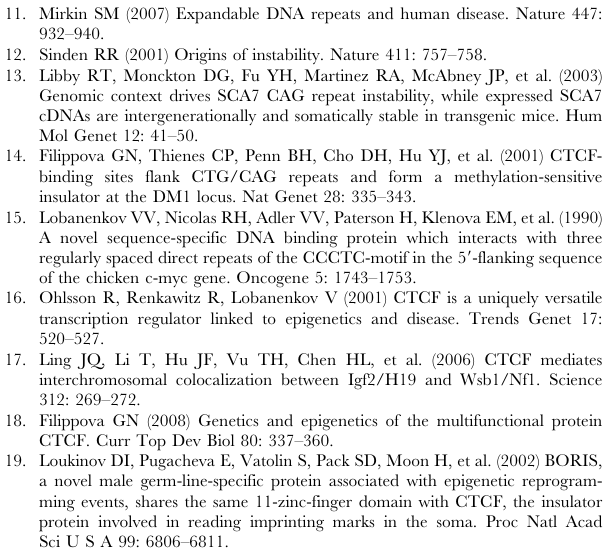
indicate shifted CTCF-DNA complexes, shifted BORIS-DNA complexes, and super-shifted BORIS-DNA complexes. Addition of CTCF-DM1 probe as cold competitor prevented CTCF-DNA and BORIS-DNA complex formation for the SCA7-CTCF-I -wt fragment, while non-specific cold competitor did not (data not shown). Figure S3 Increased somatic instability in both SCA7-CTCF -I- mut transgenic lines. Here, we see representative results for PCR analysis of somatic repeat instability for aged individuals from each of the two SCA7-CTCF-I -mut transgenic lines analyzed in this study. Note that comparable patterns of increased somatic mosaicism are observed in each lineage. Figure S4 Comparable somatic mosaicism in both SCA7-CTCF- I -mut transgenic lines. Here, we see representative images for PCR analysis of somatic repeat instability for 5 month-old individuals from each of the two SCA7-CTCF-I -mut transgenic lines analyzed in this study. Note that comparable patterns of increased somatic mosaicism are again observed at this earlier point. Figure S5 Methylation of SCA7-CTCF-I-wt probe fragment for gel shift analysis. Sss I was used to methylate cytosine residues in CpG dyads in the SCA7-CTCF-I -wt probe fragment. Digestion of control (unmethylated) and Sss I-methylated probe fragments with the methylation-sensitive restriction enzyme Nru I revealed complete methylation of Sss I-treated SCA7-CTCF-I -wt probe fragment. Figure S6 Amplicon for bisulfite sequencing for epigenotype determination. PCR amplification of bisulfite-converted genomic DNA for the fragment shown here was performed to derive CpG methylation status at the SCA7-CTCF-I binding site in murine tissues. Intron sequence is lowercase; exon sequence is uppercase. The SCA7-CTCF-I binding site is shown in blue. The thirteen CpG dyads included in the epigenotyping are shown, and the dyad with